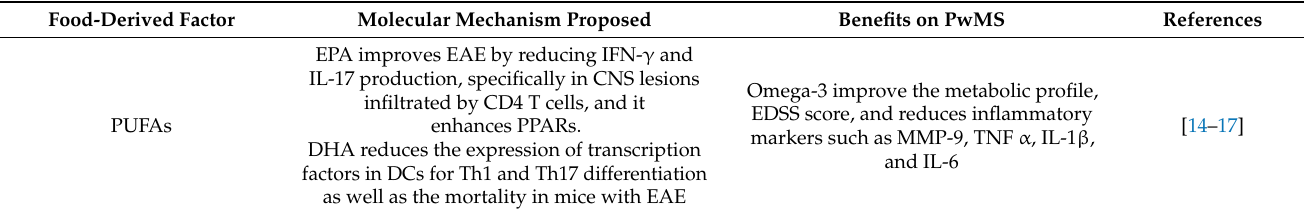
Table 1. Molecular mechanism and benefit on pwMS of the food-derived PUFA.